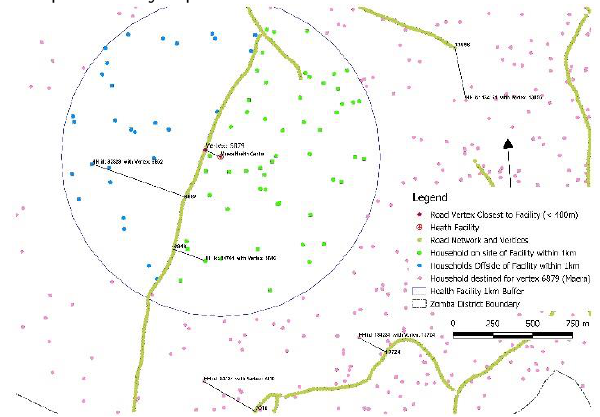
Figure 6 Straight line versus travel distance conundrum for